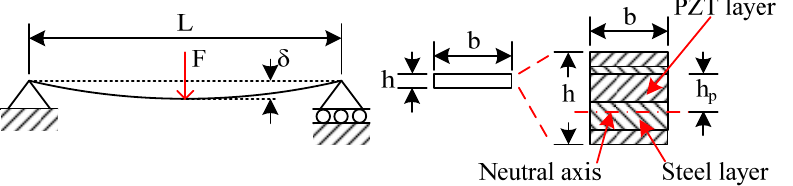
Figure 1. Schematic of the simply supported piezoelectric beam structure with a cross-sectional area (not to scale).